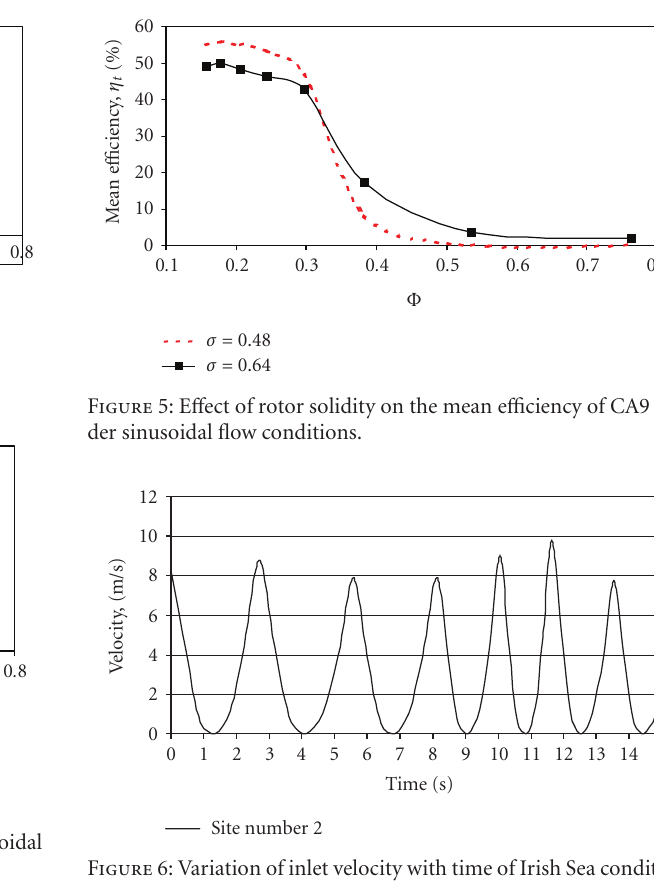
Figure 6: Variation of inlet velocity with time of Irish Sea condition